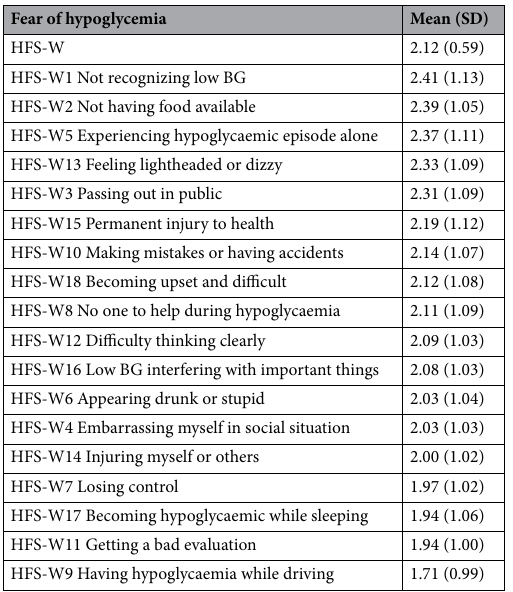
Table 2. Fear of hypoglycaemia (Worry subscale) in type 2 diabetic patients ( n = 385). SD, standard deviation; HFS-W, worry subscale of hypoglycaemia fear survey; BG, blood glucose.